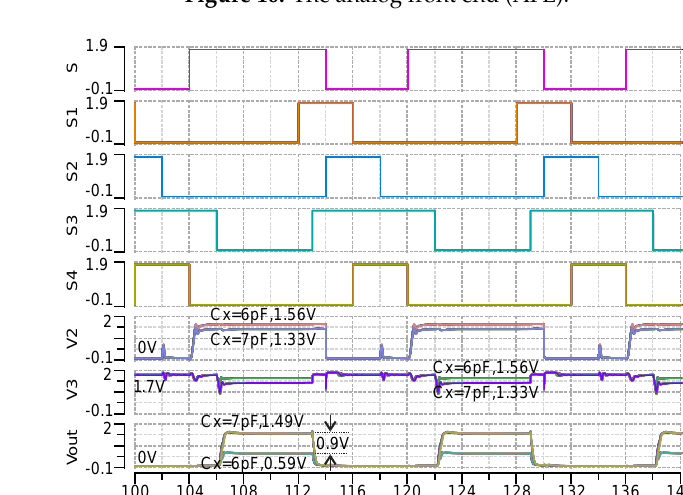
Figure 10. The analog front end (AFE).